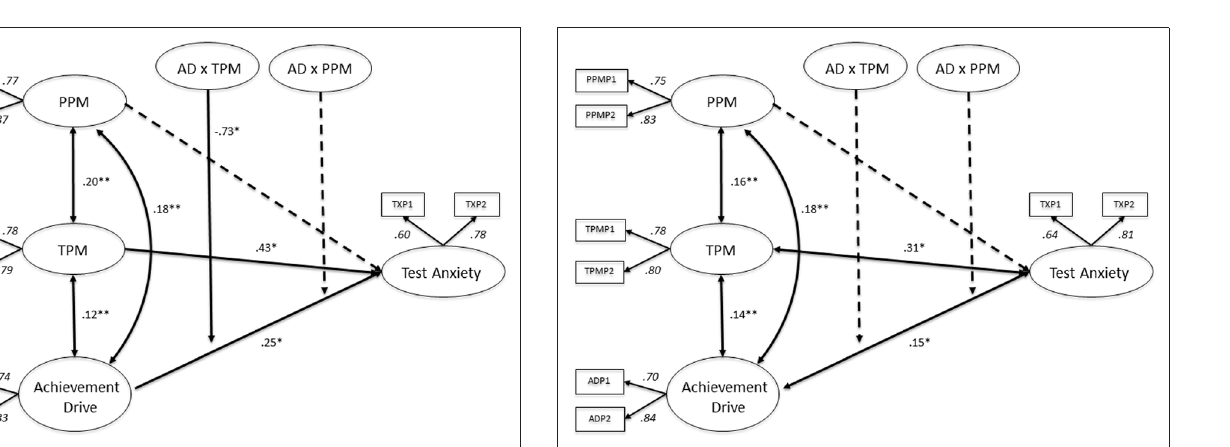
FIGURE 5 | Multigroup latent moderated structural equations (MGLMS) for the Canadian sample. Significant effects shown as unstandardized coefficients (B), bold pathways are significant at * p < 0.05, ** p < 0.001; dotted pathways are not significant. Factor loadings are standardized (based on the standardized results of the weak measurement model seen as the final model only reports unstandardized results). PPM, peers as positive motivators; TPM, teachers as positive motivators; AD, achievement drive.